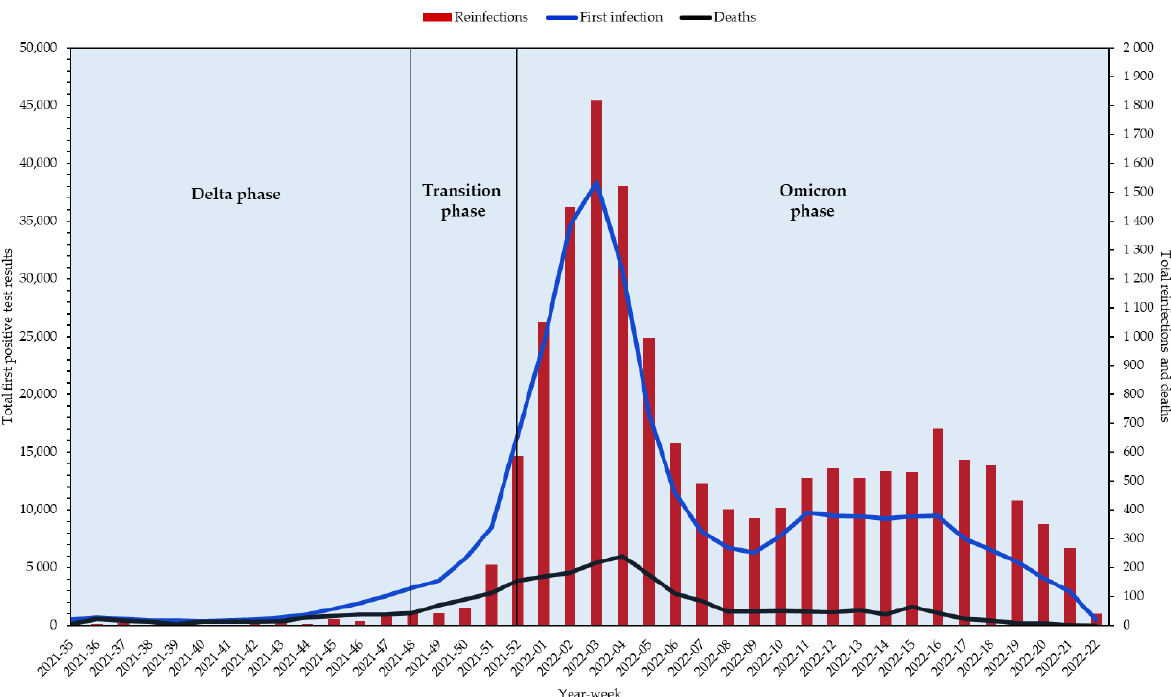
Figure 1. Weekly number of SARS-CoV-2 reinfections, primary infection and deaths in Liguria Region.